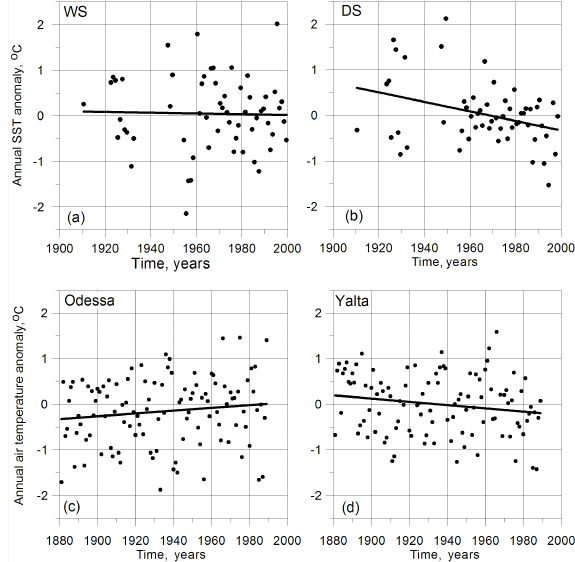
Fig. 7. Annual SST anomalies on the western shelf (a) ; deep sea (b) ; and air temperature anomalies for coastal stations Odessa (c) ; and Yalta (d) . Temperature trends ( − 0.17 (a), − 0.86 (b), +0.31 (c) and − 0.36 (d) ◦ C per 100 years) are calculated using more detailed data of monthly anomalies, which are not shown to keep the graphs uncluttered. Table 1. Statistics of the Sea Surface and Air Temperature trends. STD-ERROR PEARSON SPEARMAN KENDALL-TAU Confidence TIME- OF p-VALUE CORRELATION p-VALUE CORRELATION p-VALUE CORRELATION p-VALUE level of the SERIES TREND TREND (2-tail) COEFFICIENT (2-tail) COEFFICIENT (2-tail) COEFFICIENT (2-tail) trend